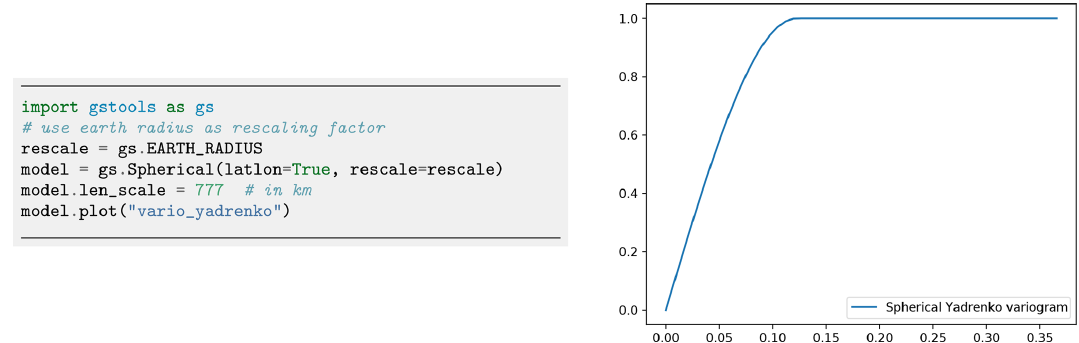
Figure 4. Initialization of a Yadrenko covariance model. We use the Earth’s radius as the rescaling factor to have a meaningful length scale. The routine vario_yadrenko still depends on the central angle given in radians.